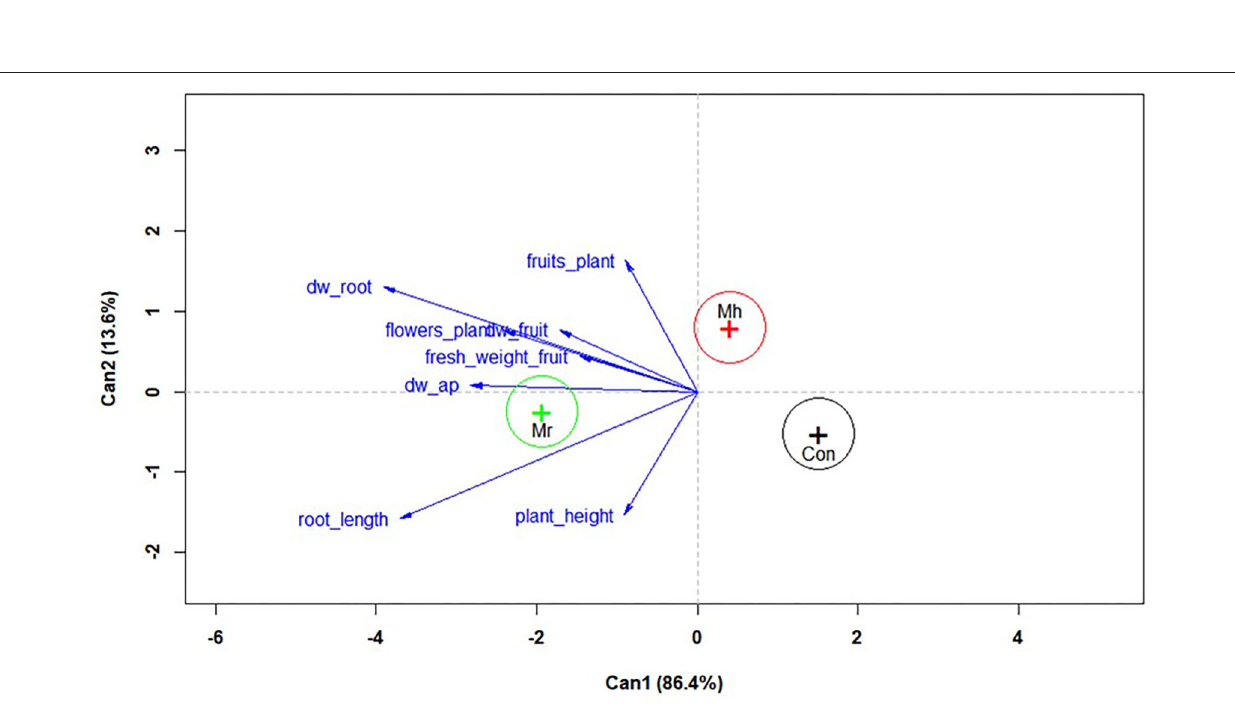
Frontiers in Sustainable Food Systems | www.frontiersin.org